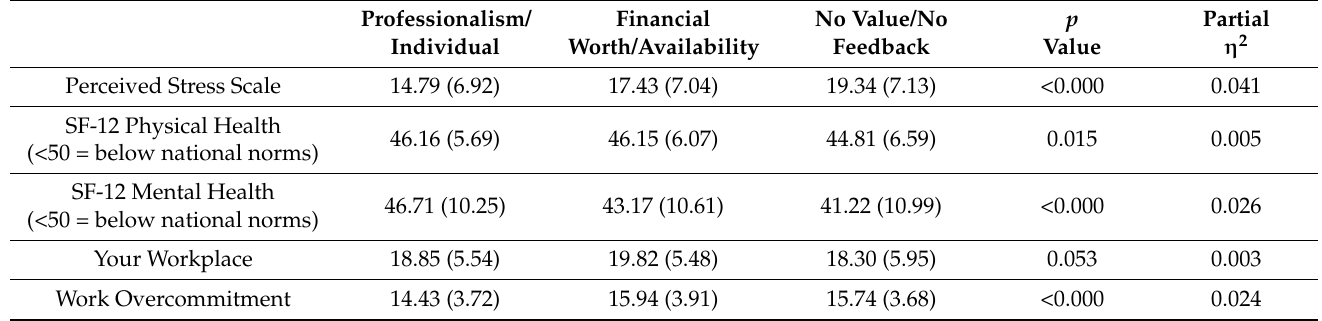
Table 5. Means and MANOVA results for continuous